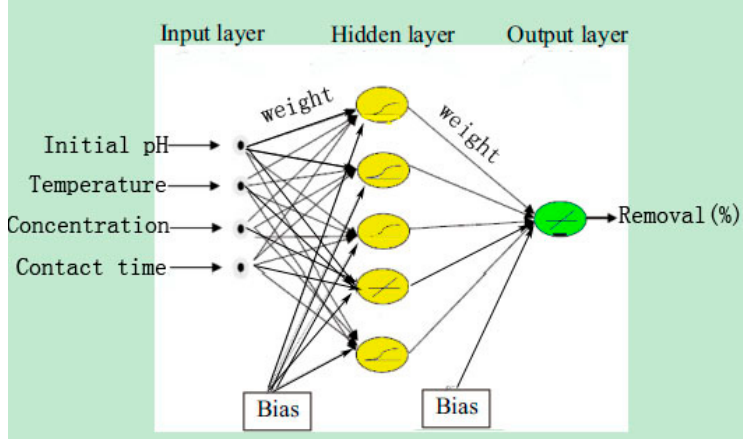
Figure 6. Illustration of back propagation (BP)-ANN architecture (the yellow oval represents neurons in the hidden layer; the green oval represents neurons in the output layer).